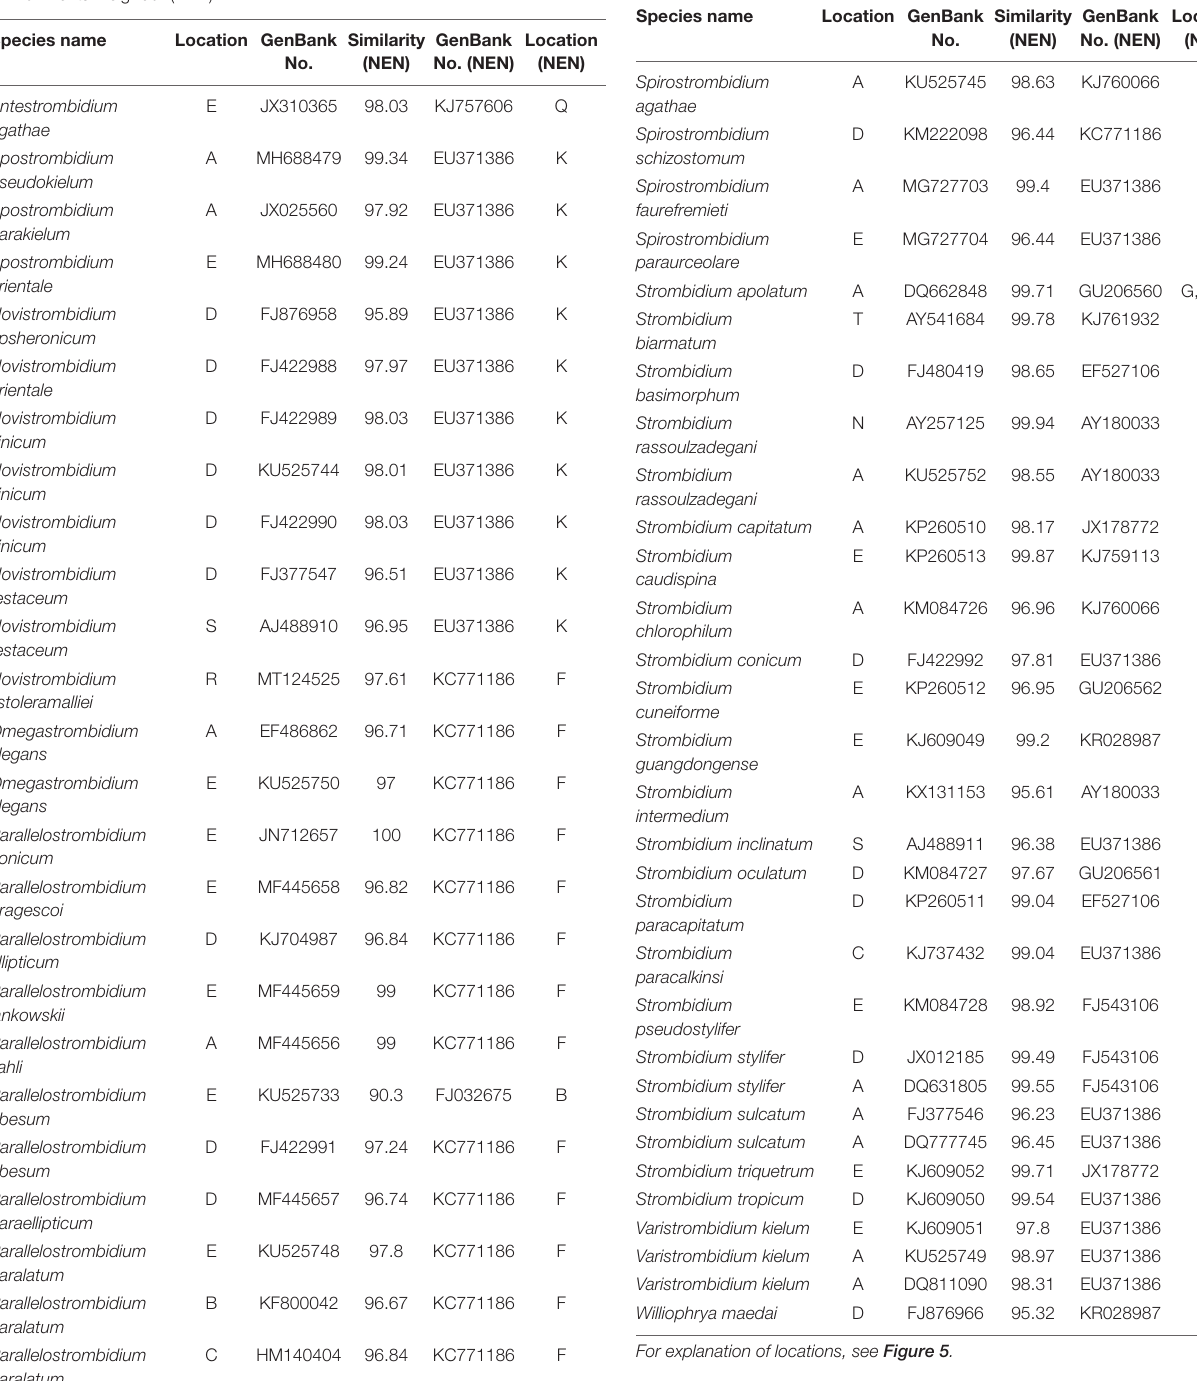
TABLE 1 | Locations of SSU rRNA gene sequences and their nearest environmental neighbor